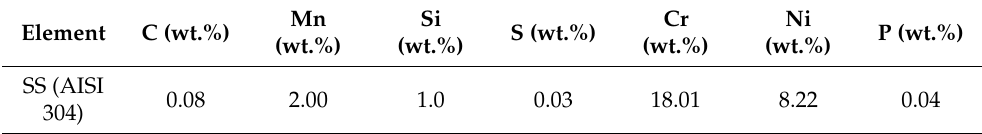
Table 2. Composition of AISI 304 [24].